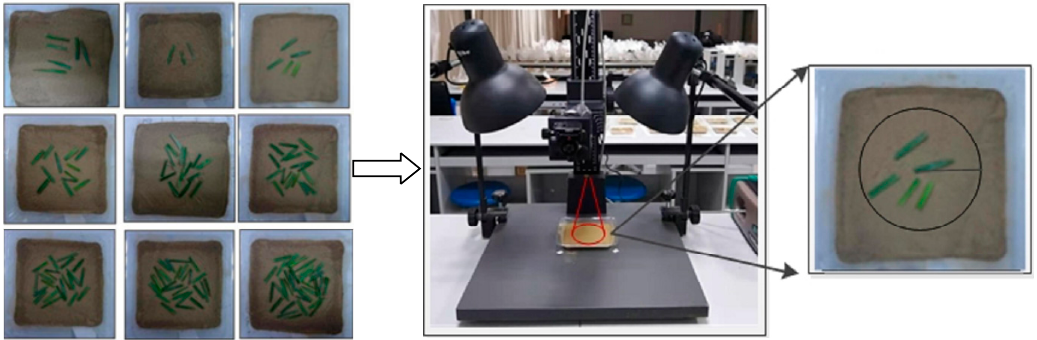
Figure 2. Mixed scenes simulation and spectral measurement.